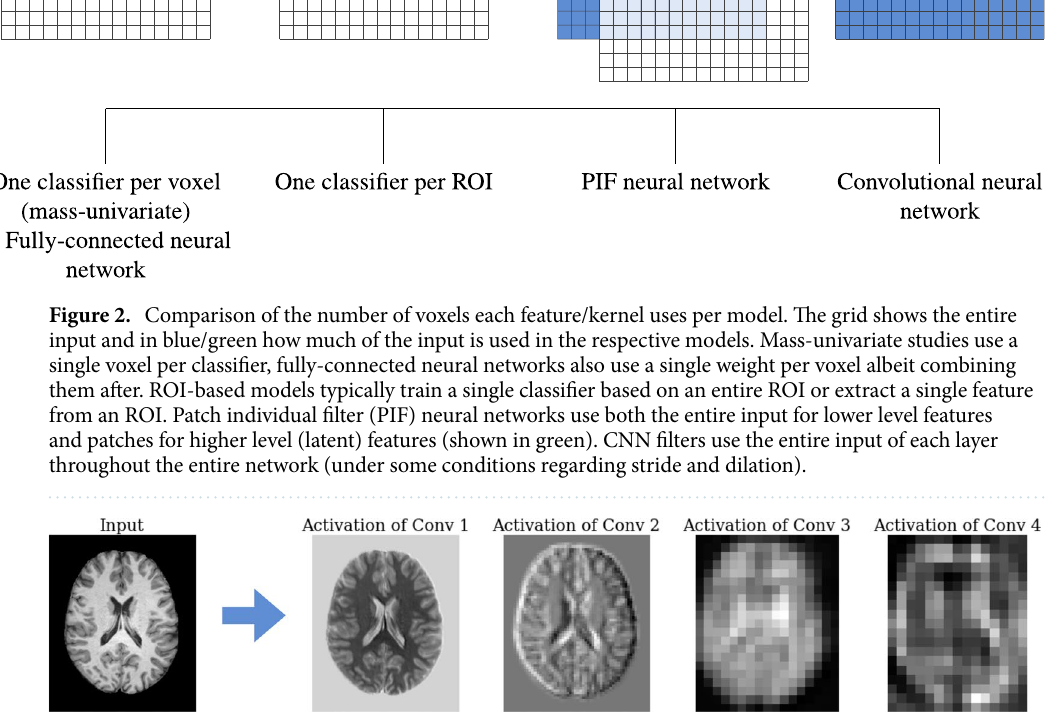
Figure 3. Latent activation maps of convolutional layers preserve the spatial representation of the